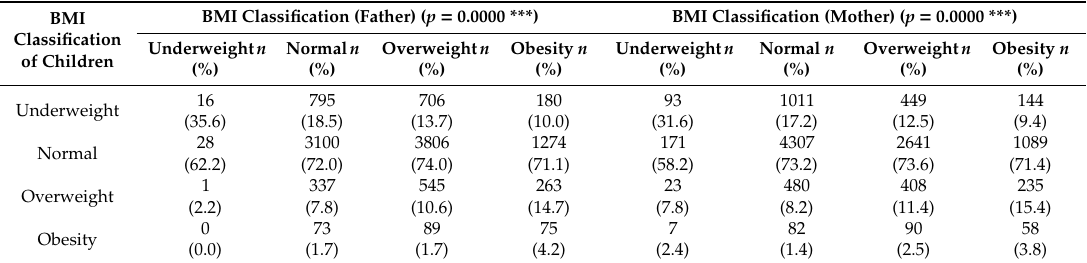
Table 3. BMI classification of children depending on classification of parent’s BMI.